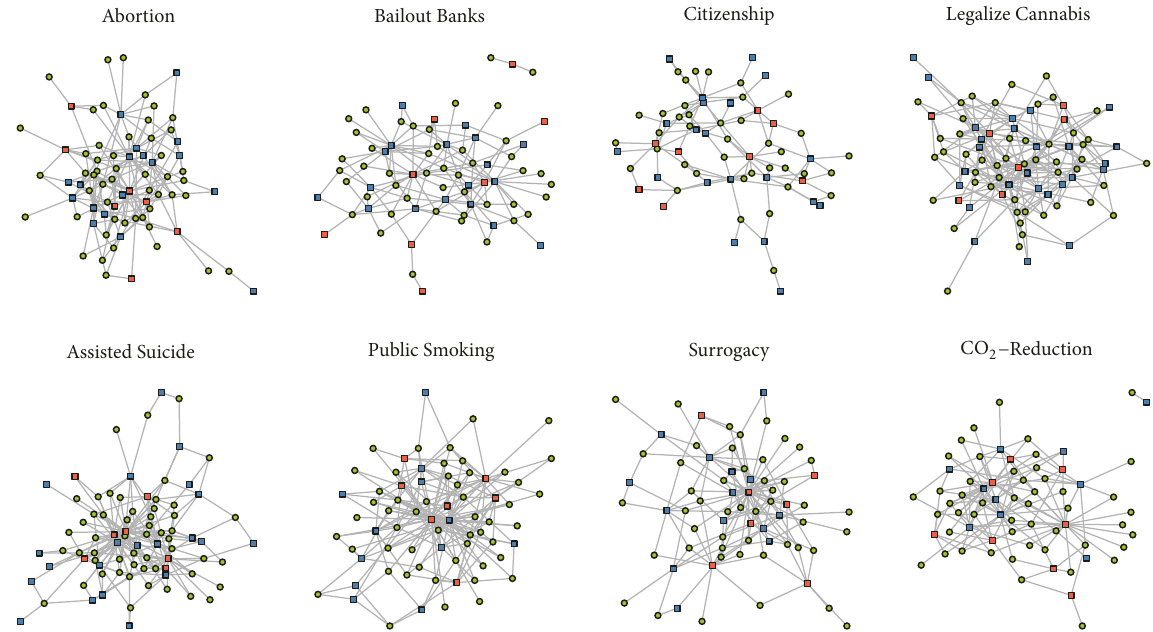
Figure 9: Bipartite adversarial policy networks for each issue, with reasons shown as boxes (red = con, blue = pro) and individuals shown as circles (green).